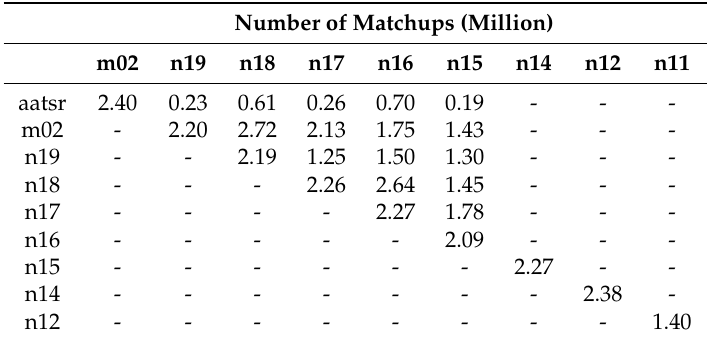
Table 2. Number of sensor-to-sensor matchups selected for different pairs of satellites. Mnemonic names (see Figure 1) in the leading column refer to the first sensor i of a matchup dataset M ij while mnemonic names in the heading row refer to the second sensor j